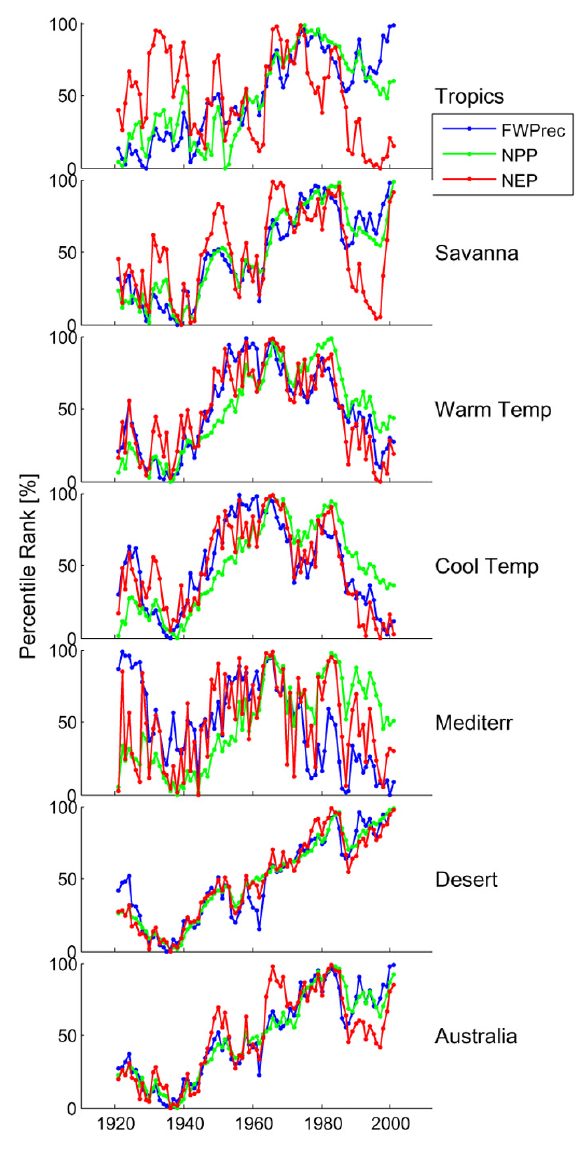
Fig. 6. Percentile rank time series of 22-yr averaged precipitation, NPP and NEP. Each point is the percentile rank of the variable (pre- cipitation, NPP or NEP), averaged over a 22-yr window, centered at the time on the x-axis. A point having a percentile rank of 100% means that all other points in the time series have lower